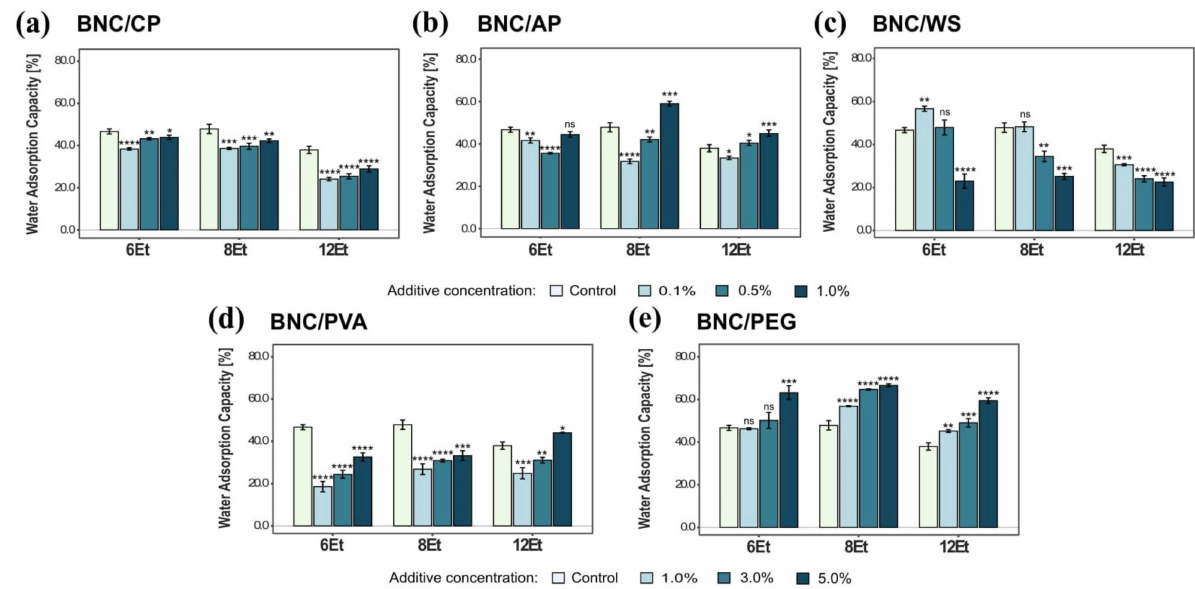
Figure 10. Water adsorption capacity of bacterial cellulose composites produced by K. hansenii H3 (6Et), K. rhaeticus K4 (8Et) and the strain isolated from balsamic vinegar (12Et). ( a ) BNC/CP, ( b ) BNC/AP, ( c ) BNC/WS, ( d ) BNC/PVA, and ( e ) BNC/PEG. Statistically significant differences were calculated using a one-way ANOVA with Tukey’s multiple comparison post-hoc test and are shown as * = p ≤ 0.05, ** = p ≤ 0.01, *** = p ≤ 0.001, and **** = p ≤ 0.0001, compared to control (native)